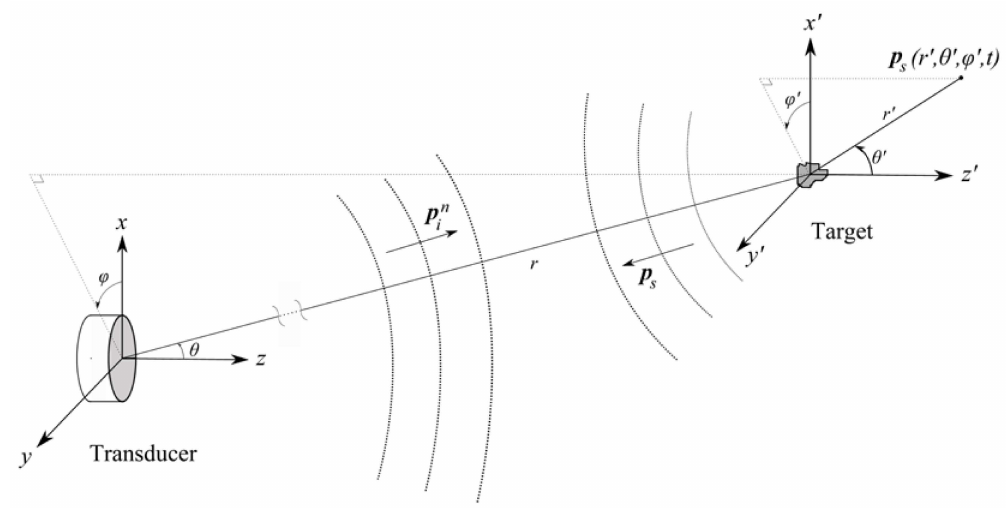
Figure 1. Sketch of the acoustic system for single-target backscattering, with an electroacoustic transducer operating as a transmitter and receiver of ultrasound, acoustic backscattering from a single scattering object (target) in a homogeneous fluid medium, and the two spherical coordinate systems 1 and 2 used for the transmitted and scattered sound wave fields, respectively. The target center is located at position ( r , θ , φ ) relative to coordinate system no. 1. (Reproduced from [22], with permission from the Institute of Marine Research,